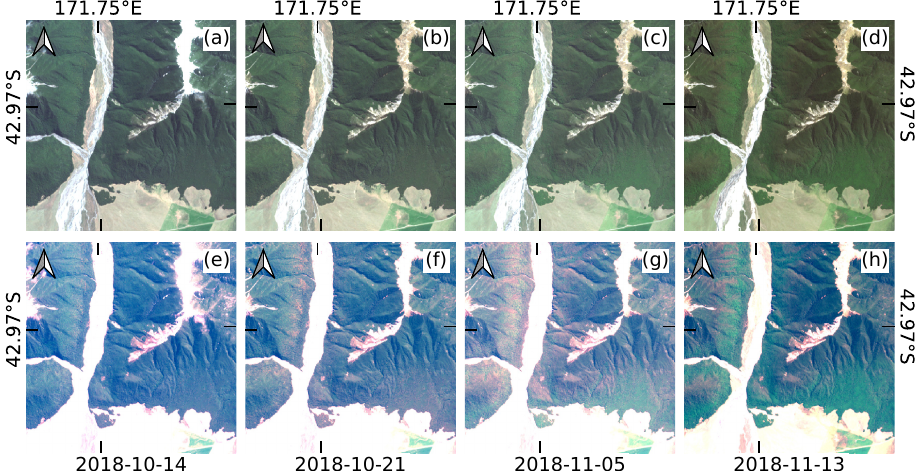
Figure 1. Sentinel-2 imagery from the Hawdon Valley, South Island, New Zealand, showing a flowering event during the spring of 2018: ( a – d ) are natural color; ( e – h ) are natural color with an exaggerated stretch to amplify the “red” band (Band 4). The images are organized by column, e.g., ( a , e ) are the natural color and stretched color for 14 October 2018, respectively. The NDYI is similar to the well-known normalized difference vegetation index (NDVI) [32], using the “red” (Band 4665 ± 15 nm) and “green” (Band 3560 ± 18 nm) Sentinel-2 bands instead of the “near-infrared” and “red” bands. It is also very similar to the green-red vegetation index (GRVI) [33,34], with the order of the bands merely reversed: